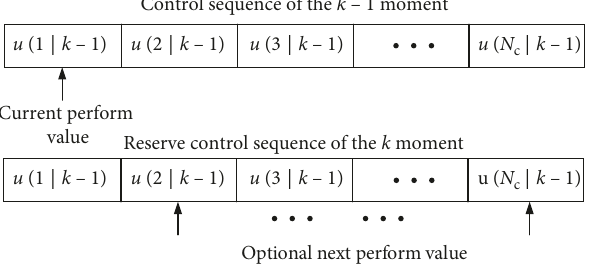
t response curve. Control sequence of the k – 1 moment